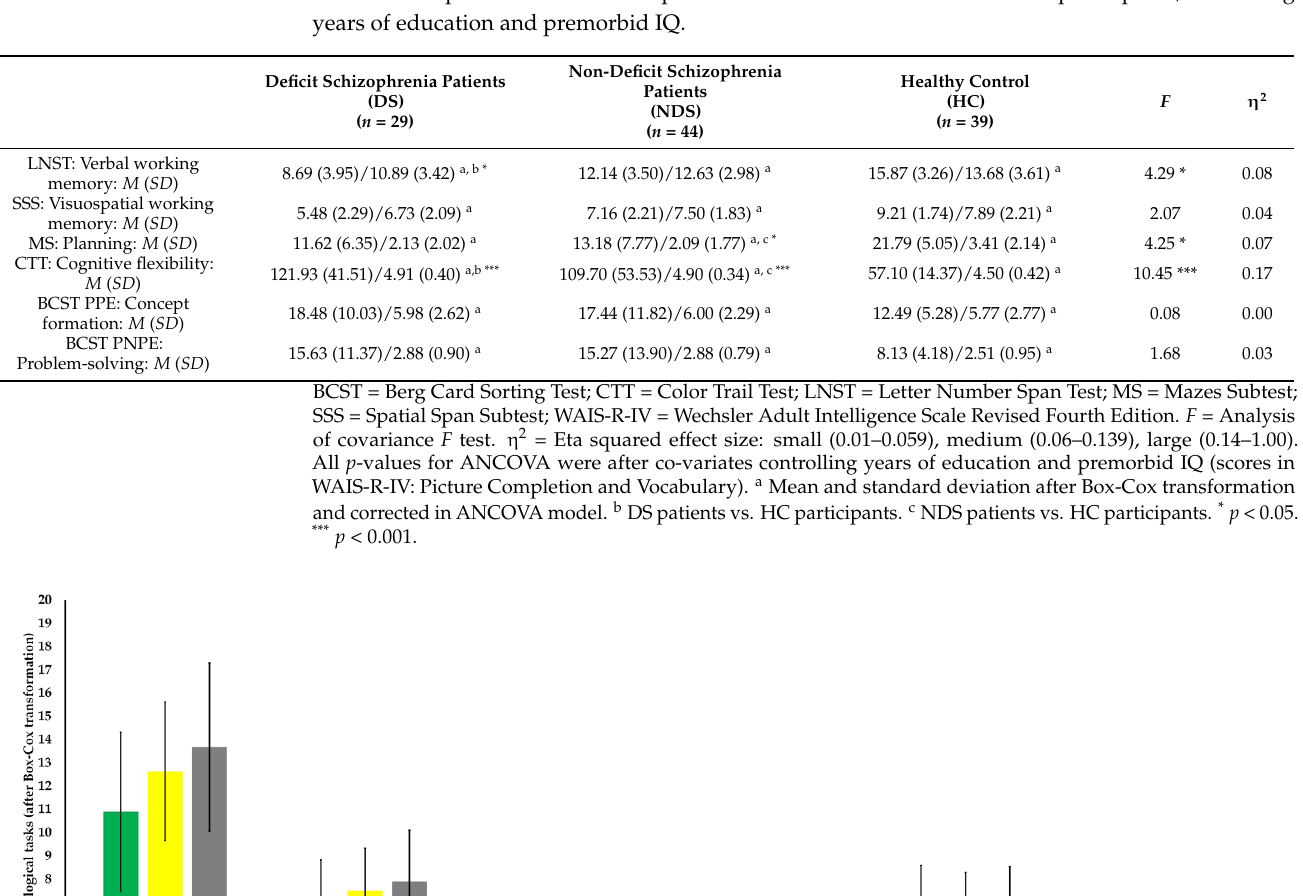
Table 3. Comparison of different aspects of executive functions between the two patient groups, controlling premorbid IQ and psychopathological symptoms.